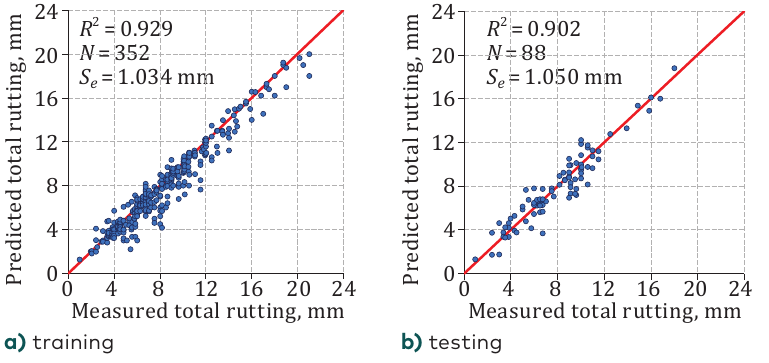
a) Figure 12. Measured and predicted rutting of NN-pro